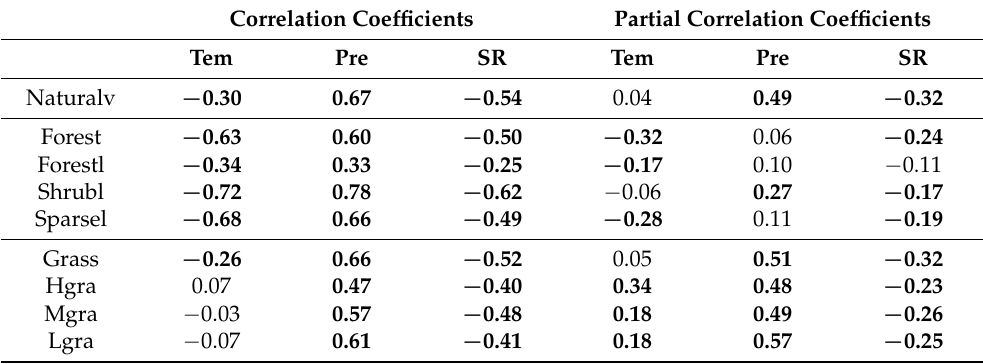
Table 3. Correlation coefficients and partial correlation coefficients between the mean NDVI and the mean climate in the arid region of northwestern China (SR: solar radiation; Pre: precipitation; Tem: temperature; significant correlation coefficients at the 0.05 significance level are indicated in bold). Correlation Coefficients Partial Correlation Coefficients Tem